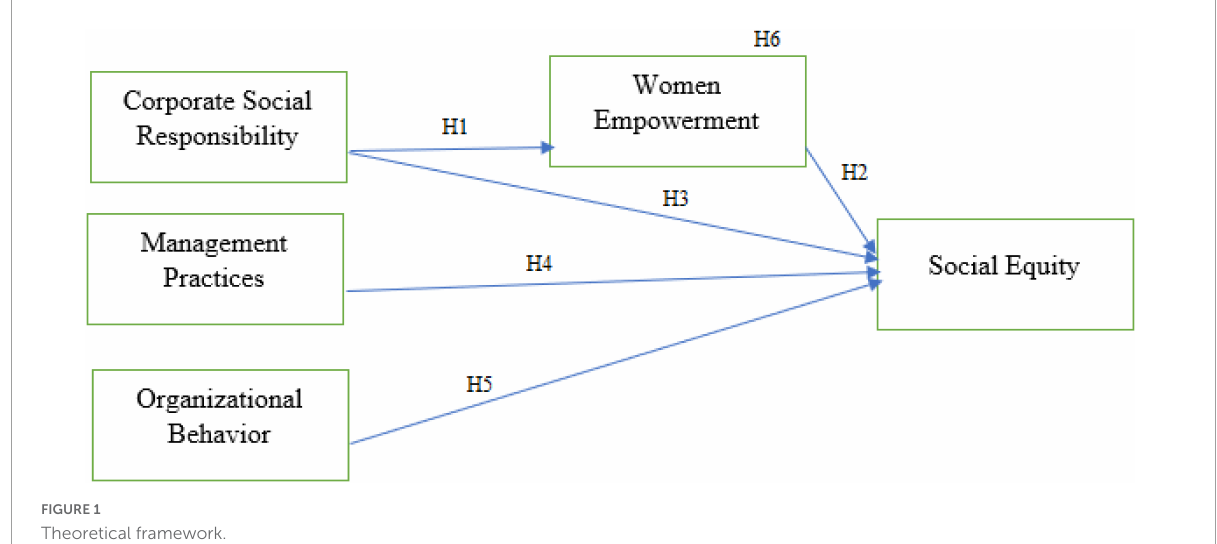
FIGURE1 Theoretical